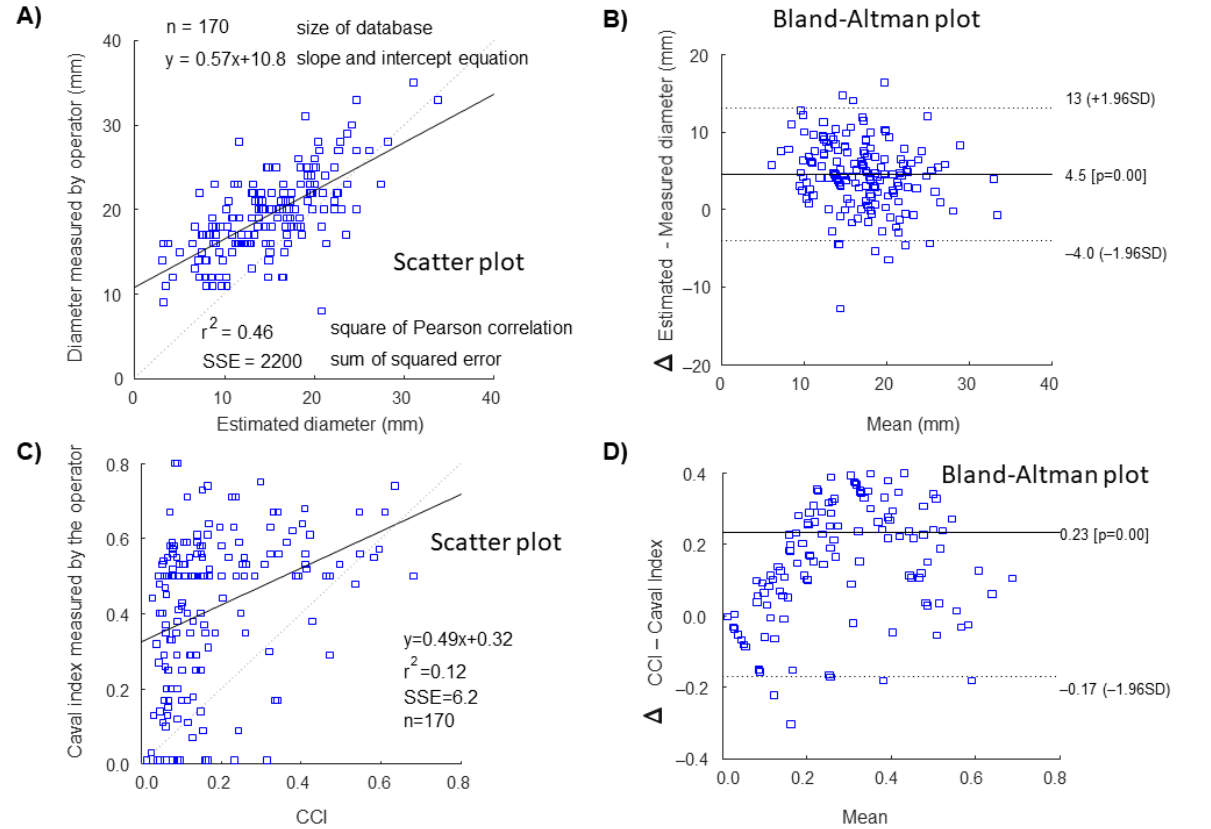
Figure 2. Comparison of IVC properties measured by the operator or estimated by the semi- automated algorithm. ( A ) Scatter plot and ( B ) Bland–Altman representation of IVC size. ( C ) Scatter plot and ( D ) Bland–Altman representation of IVC pulsatility (in terms of caval index after sniff measured by the operator and CCI obtained from short US